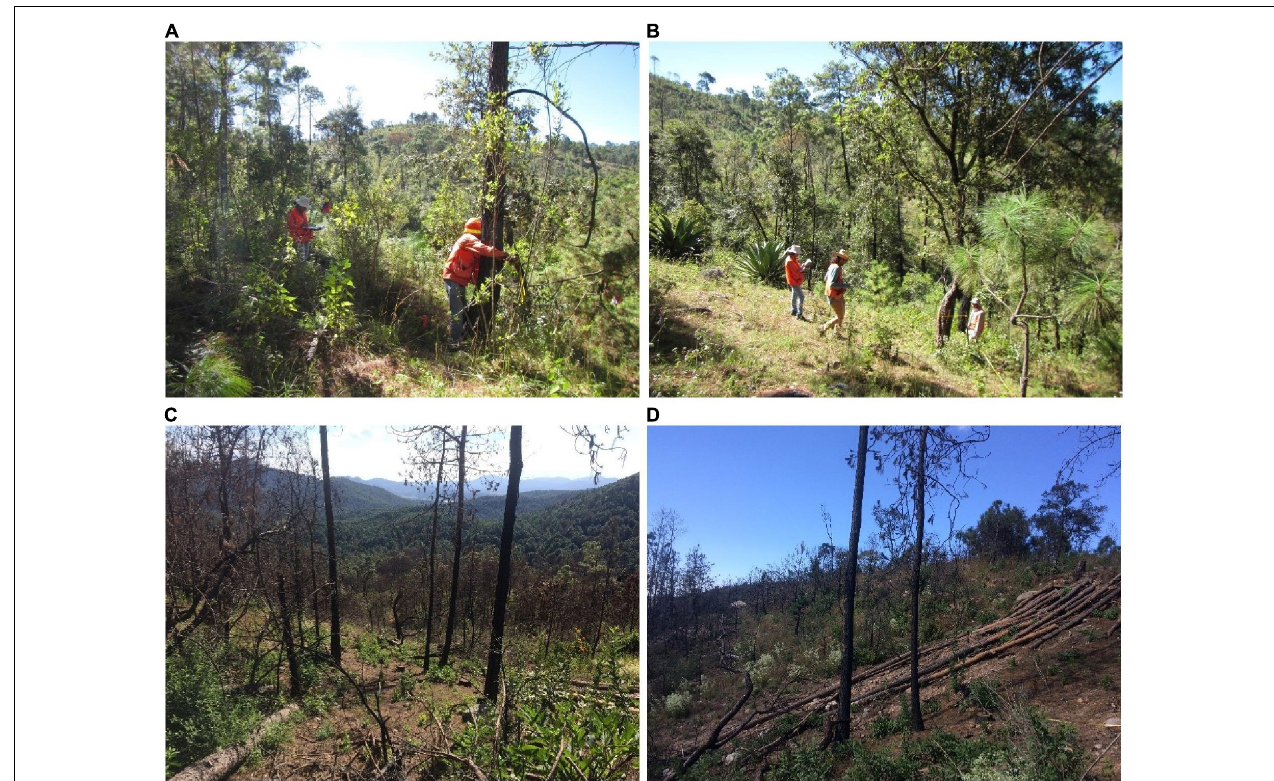
FIGURE 7 | The FIPRODEFO field team (A) measuring forest plots following the degradation PSP protocol and (B) using plot maps to relocate individual trees. Plot 8 in census 2 showing (C) standing live stems damaged by fire and stumps and (D) trunks of cut